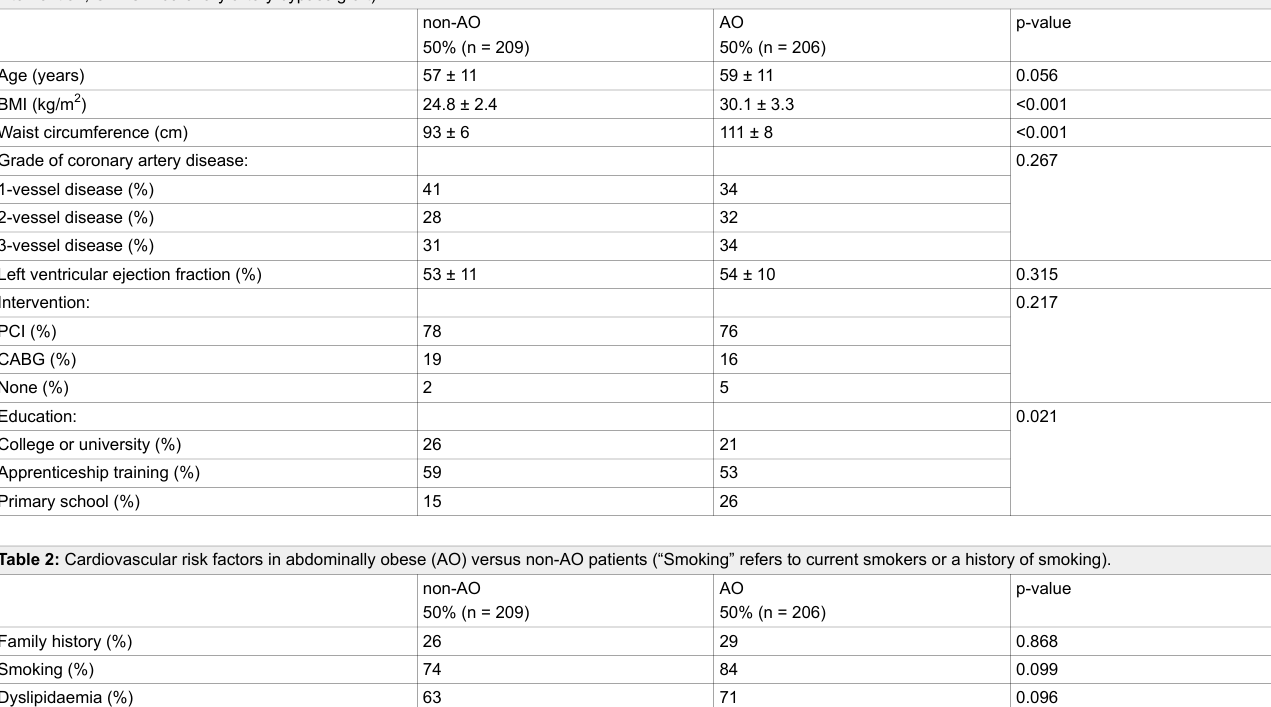
Table 1: Sociodemographic and clinical characteristics of abdominally obese (AO) versus non-AO patients (BMI = body-mass index, PCI = percutaneous coronary intervention, CABG = coronary artery bypass graft).